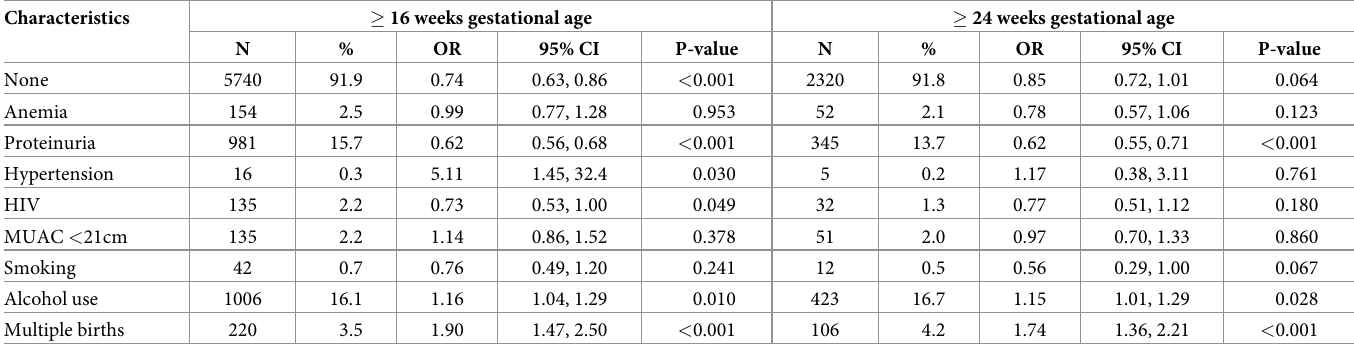
Table 4. Obstetric risk factors identified at ANC-1 associated with delayed antenatal care in univariate models. Characteristics